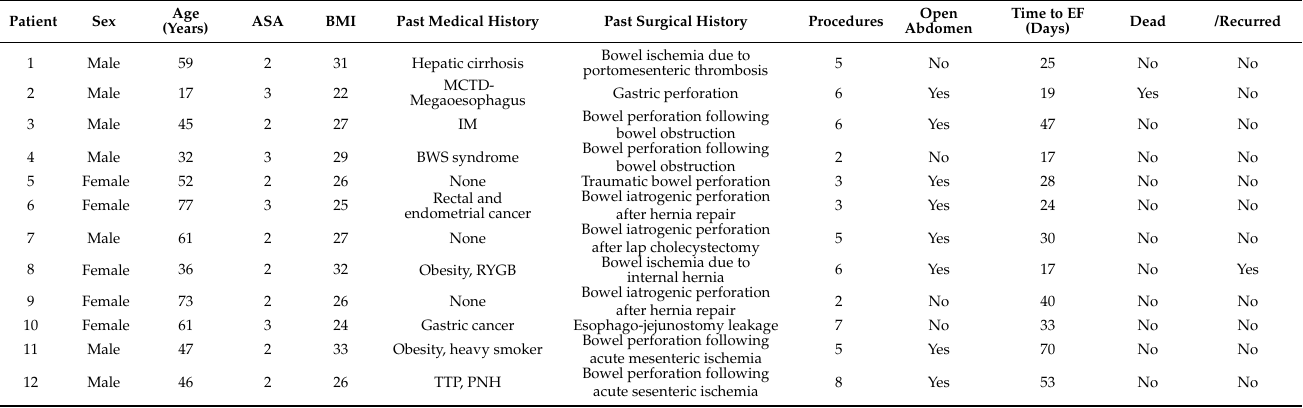
Table 1. Clinical and surgical history until enteric fistula